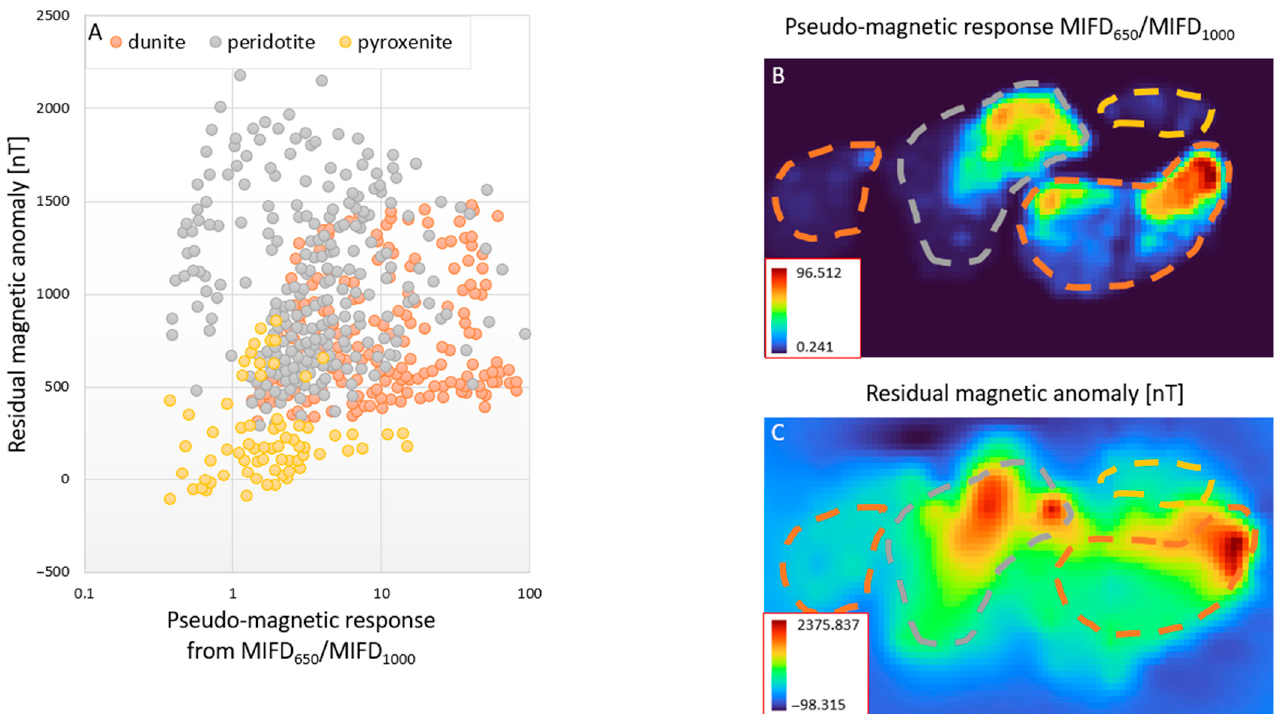
Figure 13. ( A ) Correlation plot between the residual magnetic anomaly data (after IGRF removal and high-pass filtering) and the pseudo-magnetic responses calculated by forward of MIFD 650 /MIFD 1000 -ratios that are considered as “susceptibility” values at the surface. The lithologies located immediately underneath data point locations are color-coded: dunites (orange), peridotites (gray), and pyroxenites (yellow) ( B , C ) show the calculated pseudo-magnetic response of the MIFD 650 /MIFD 1000 -ratio and the residual magnetic anomaly map, respectively. The dashed lines sketch the shapes of mapped dunites (orange), peridotites (gray), and pyroxenites (yellow) lithological units.